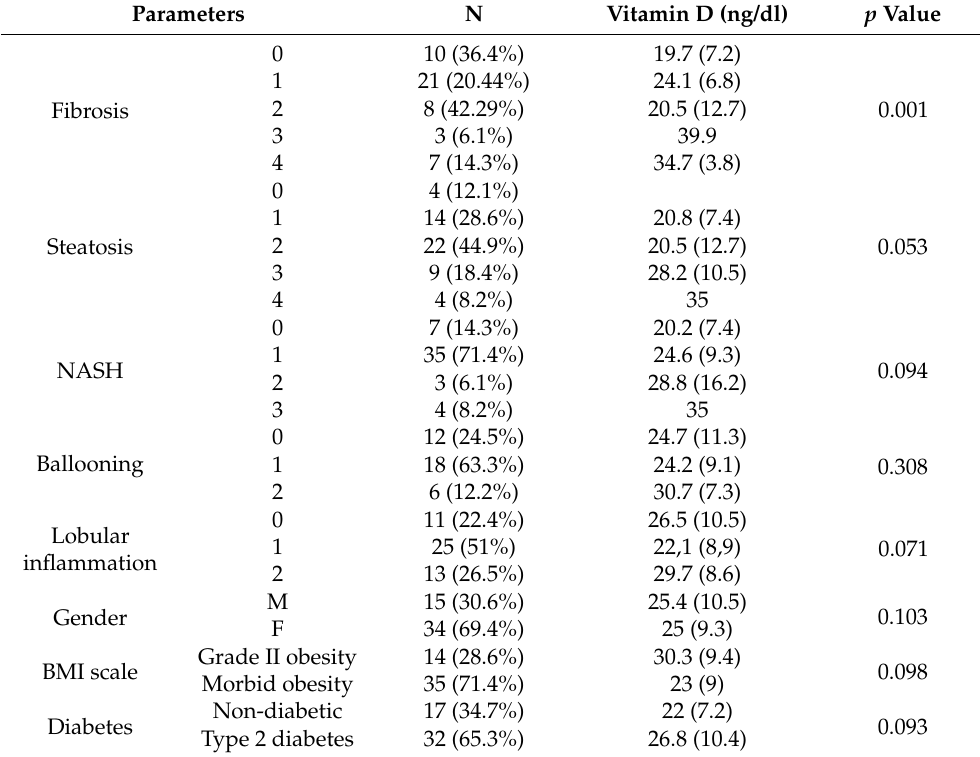
Table 2. Vitamin D association between groups.